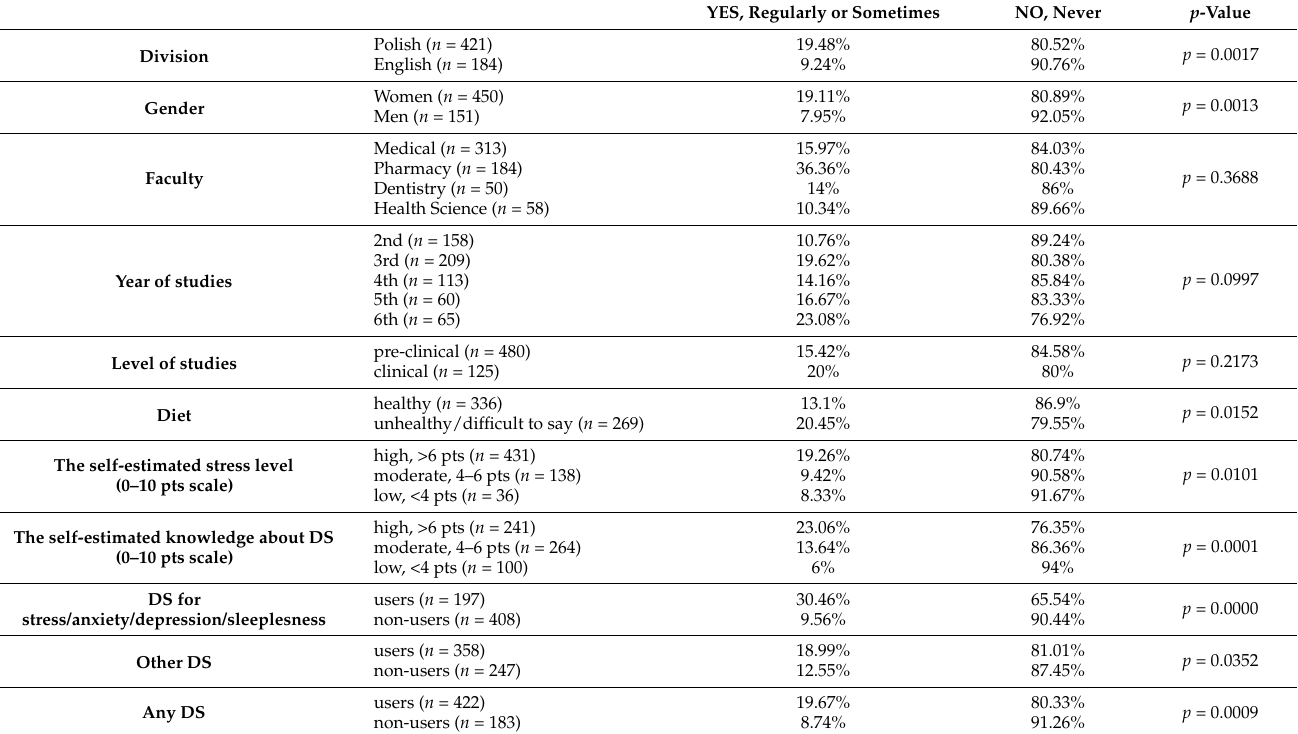
Table 3. The use of prescription-only medicines (POM) for stress, anxiety, depression, or sleeping problems among Wroclaw Medical University Students in the academic year 2020/2021. Students who marked the answer “prefer not to disclose” are not included in the statistical analysis. Analyses were performed using the chi-square